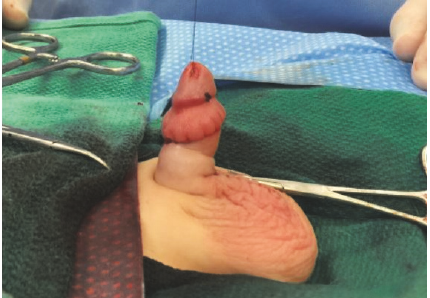
Figure 4: Redemonstration of the penopubic and penoscrotal angles in the two-year-old patient.